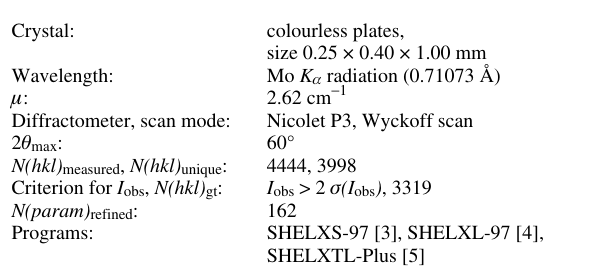
Table 1. Data collection and handling.